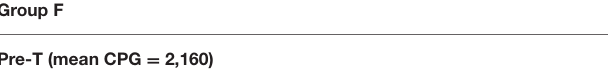
TABLE 5 | Results of mean Giardia cyst per gram (CPG) and efficacy (%) of the treatments performed in Group M, on study days (SDs) 7–12 and SDs 19–24. Group